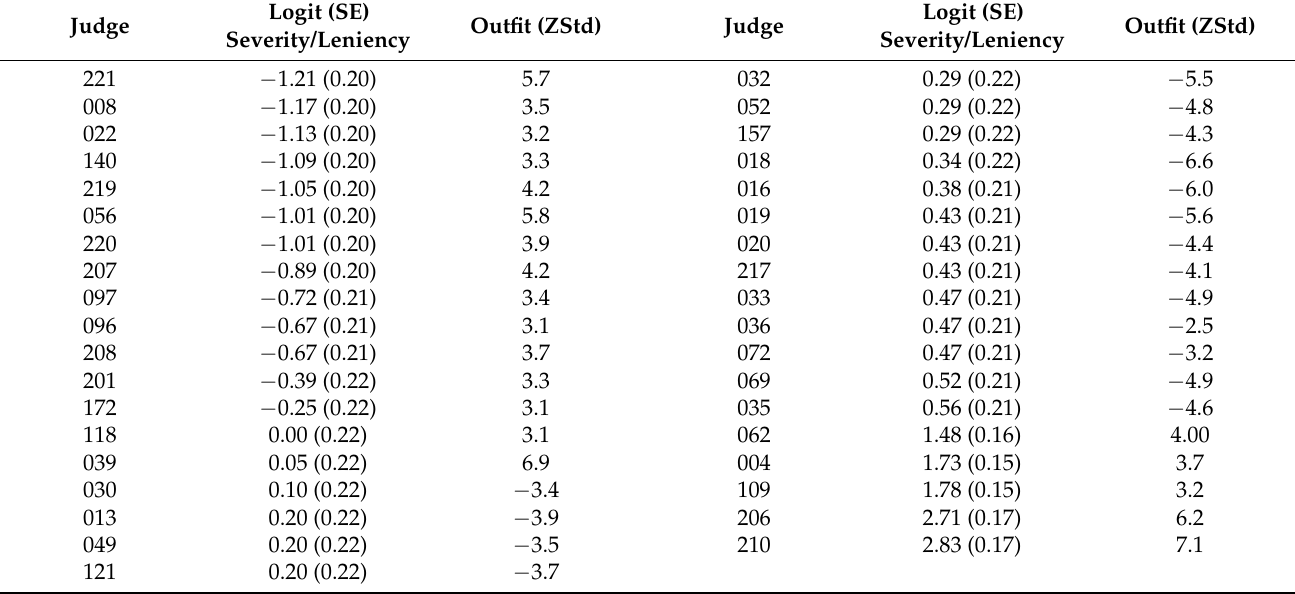
Table 6. Maladjusted judges to many-facet Rasch measurement (MFRM) model ( n =